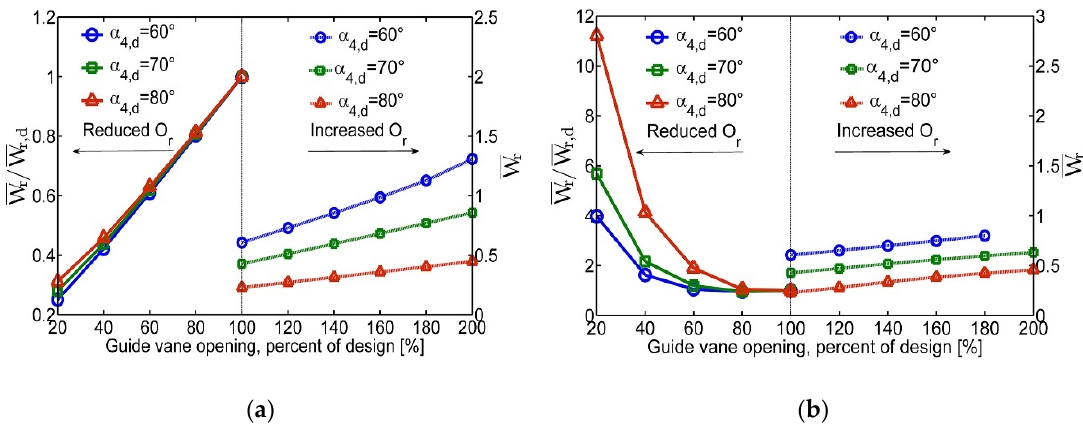
Figure 7. E ff ect of design guide vane outlet flow angle on the change characteristics of W r with variable Figure 7. Effect of design guide vane outlet flow angle on the change characteristics of r W with guide vane opening: ( a ) constant pressure ratio; ( b ) constant flow coe ffi cient ( β 6 m = − 52.5 ◦ , β 4 = − 30 ◦ variable guide vane opening: ( a ) constant pressure ratio; ( b ) constant flow coefficient